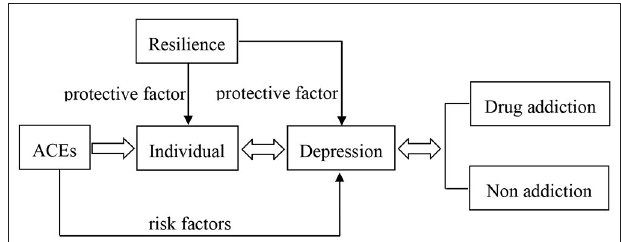
FIGURE 1 | The relationship between ACEs, drug addition, depression, and resilience.